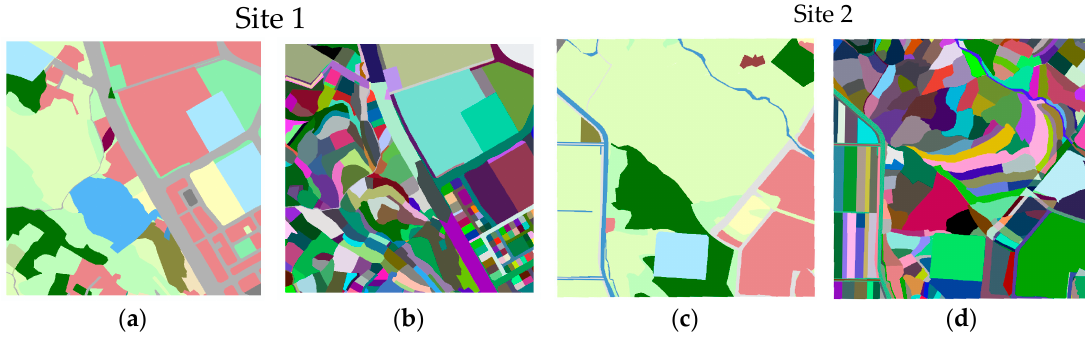
Figure 9. Cadastral maps rasterized with ( a ) land category at Site 1, ( b ) parcel ID at Site 1, ( c ) land category at Site 2, and ( d ) parcel ID at Site 2.